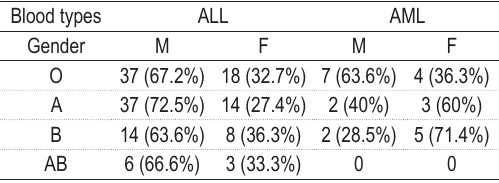
TABLE 6. Distribution of blood types based on the